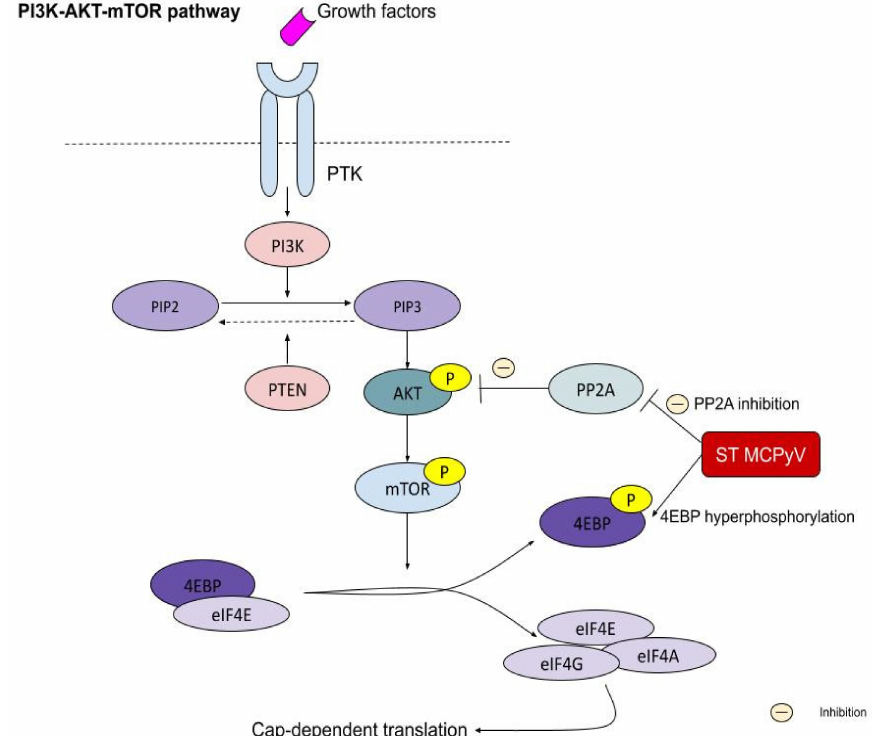
Figure 4. PI3K–AKT–mTOR pathway. ST MCPyV inhibits PP2A as well as promotes 4EBP hyperphosphorylation, resulting in increased frequency of cap-dependent translation. (PTK—protein tyrosine kinase, PI3K—phosphatidylinositol-3-kinase, PIP2—phosphatidylinositol 4,5-bisphosphate, PIP3—phosphatidylinositol 4,5-bisphosphate, PTEN—phosphatase and tensin homolog, AKT—AKT serine/threonine kinase, mTOR—mechanistic target of rapamycin kinase, PP2A—protein phosphatase 2A, 4EBP—4E binding protein, eIF4E/4G/4A—eukaryotic translation initiation factor 4E/4G/4A, ST MCPyV— small T